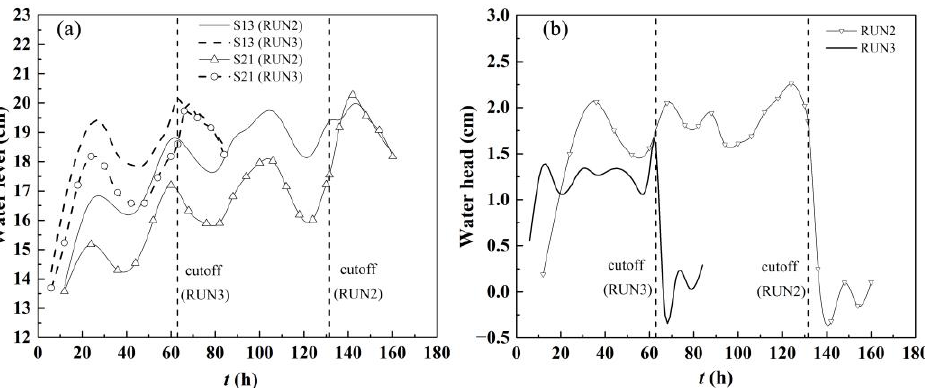
Figure 6. Variation in the ( a ) water level and ( b ) water level drop from upstream to downstream of the neck.